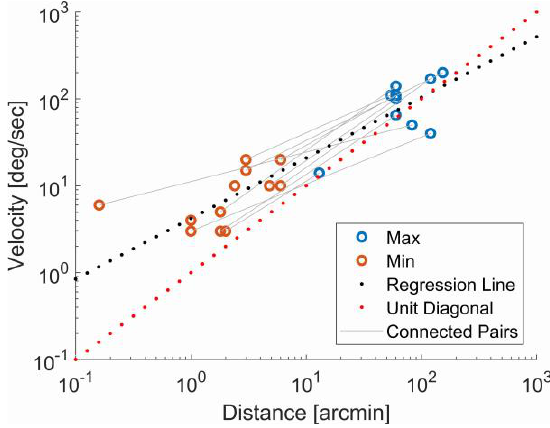
Figure 2: Minimum and maximum values of peak velocity and distance as extracted from the reviewed literature. The blue dots indicate the reported maximum velocities and the red dots the reported minimum velocities. Maximum and minimum points from the same publication are linked by a grey line. The red dotted line shows the unit diagonal while the black dotted line shows a regression line fitted to the data. To ensure that distance and velocity samples corre- spond to the same saccade only values read from graphs are included. The grey lines connecting one orange to one blue point represent samples reported in the same